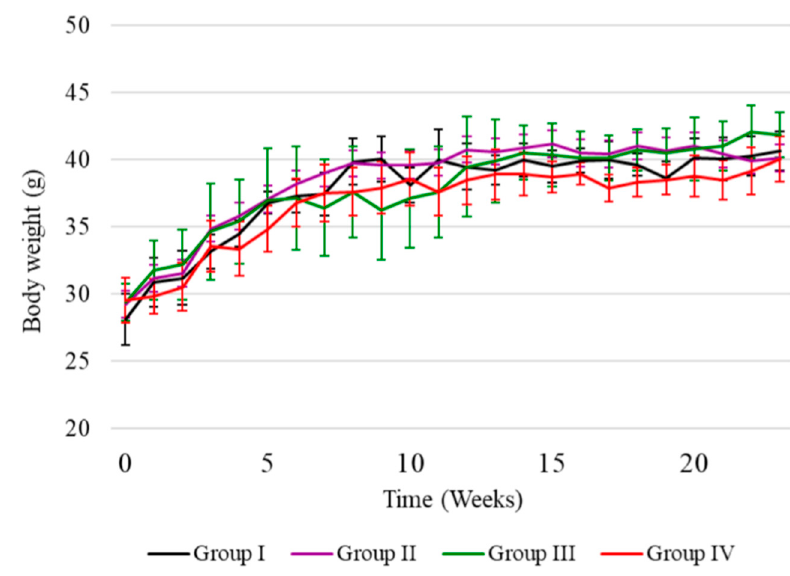
Figure 3. Time evolution of bodyweight of mice exposed to different concentrations of arsenic.